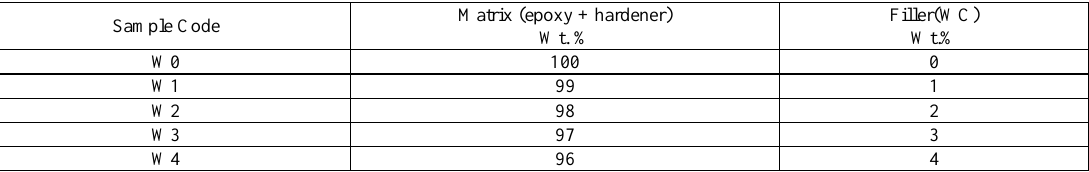
Table 1. Different types of composite samples